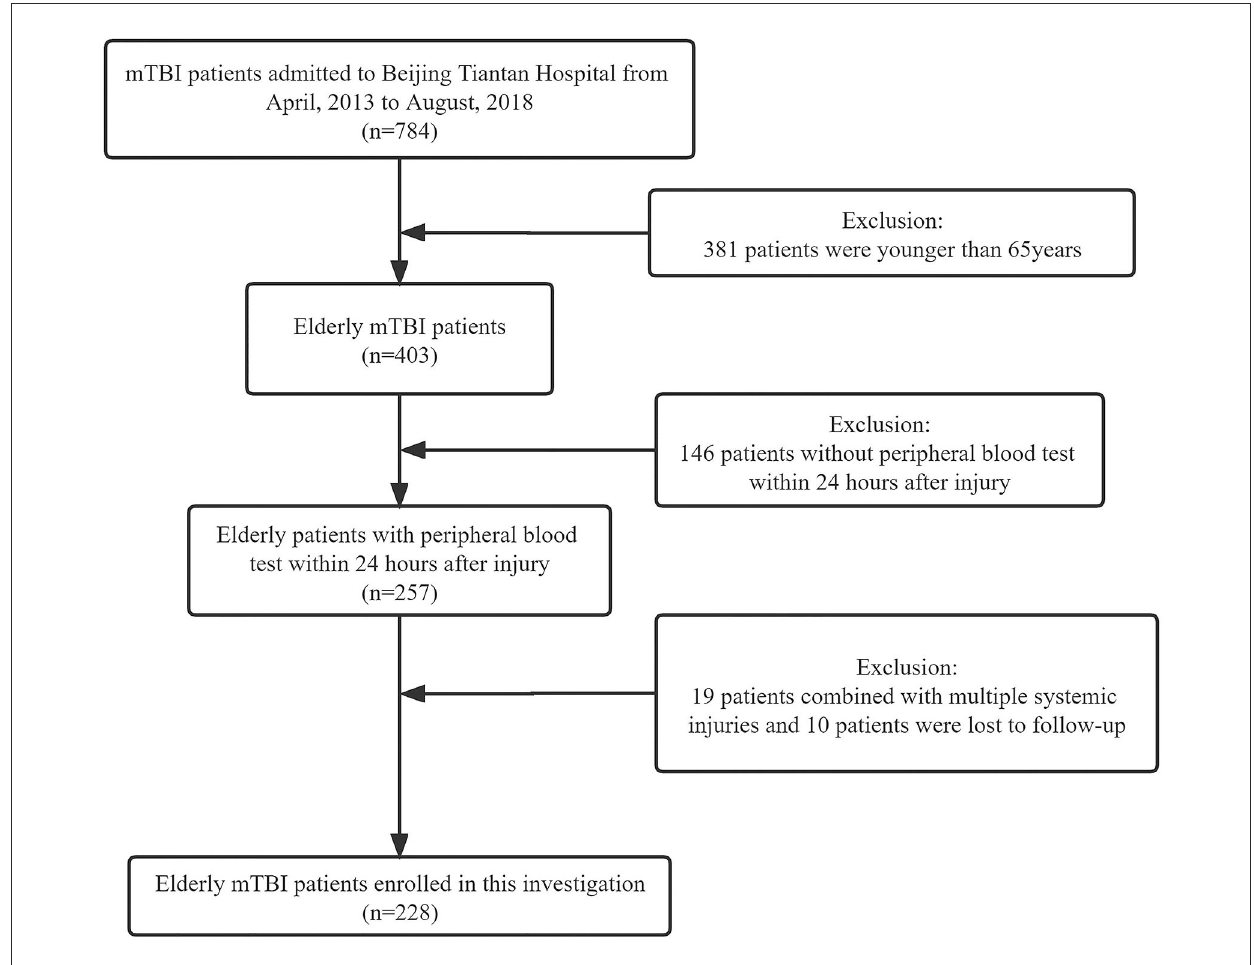
FIGURE1 Flow diagram of the study participants. mTBI, mild traumatic brain